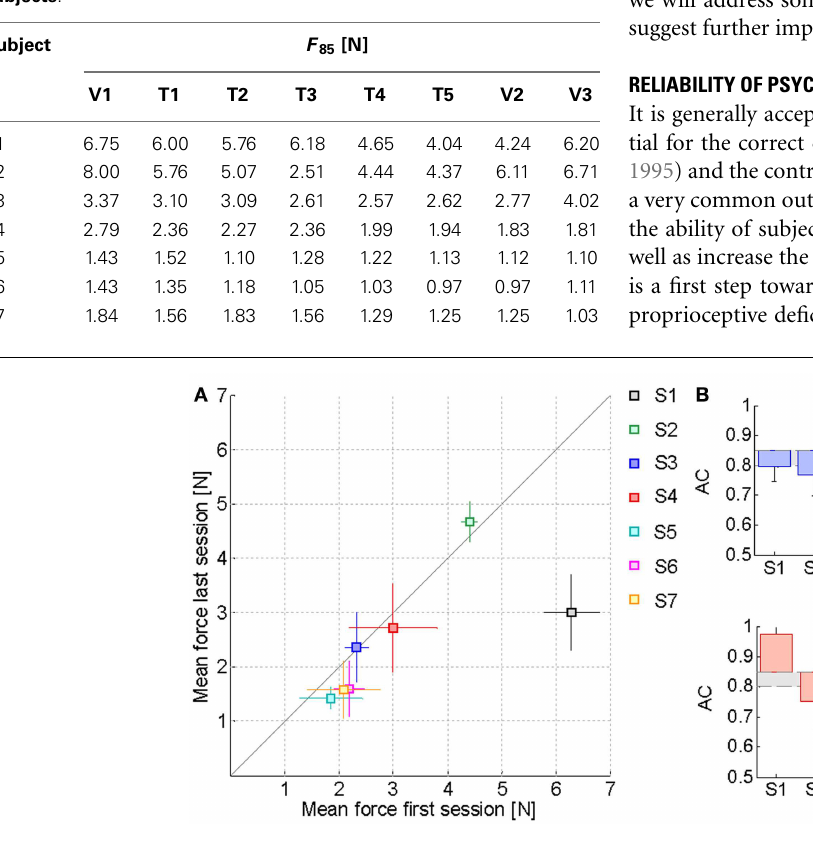
FIGURE 4 | Effect of training on the assistive force . (A) Mean F PEAK values and corresponding standard deviation over the middle trials of the first training session compared to the last one.The solid line represents the equality condition. Points that lie below the line indicate that the average force needed by the subjects for carrying out the reaching task has diminished, while points above the line denote an increase in the average